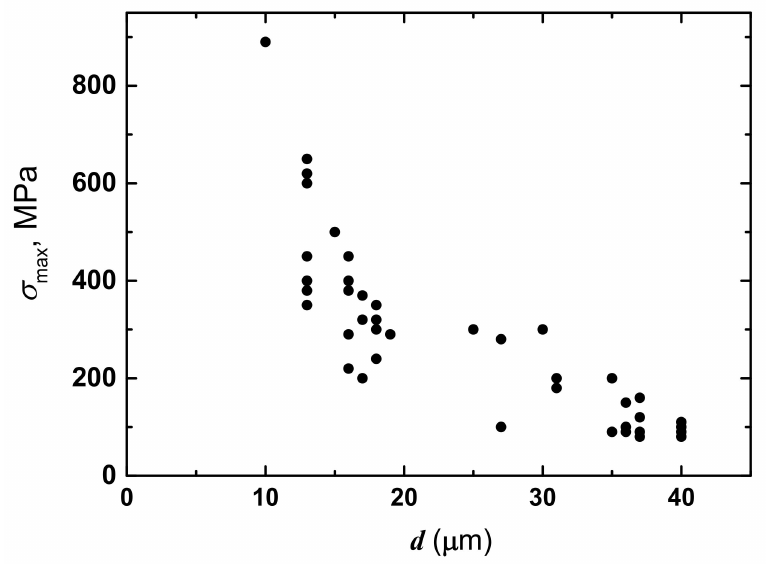
Figure 1. Dependence of the maximum stress σ max in linear elastic region on the diameter d of the initial natural silk